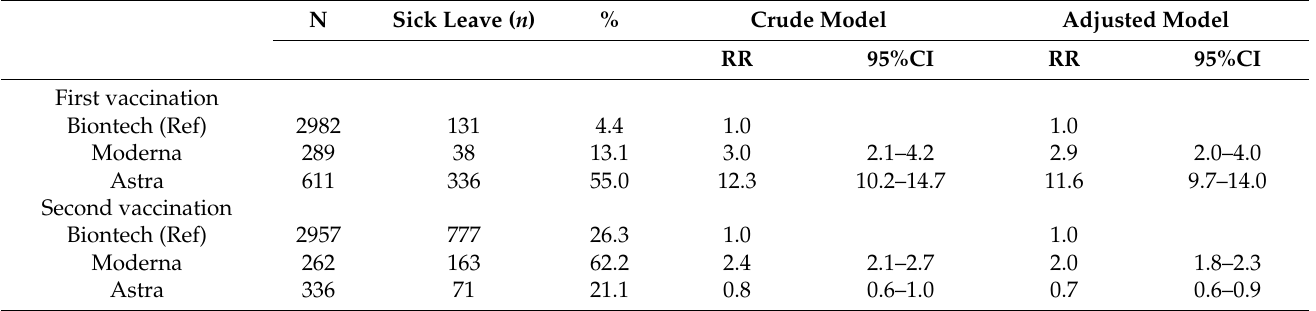
Table 6. Association between type of vaccination and proportion of subjects with at least one sick leave day after vaccination, crude, and multiple adjusted risk ratios with 95% confidence intervals. N Sick Leave ( n )